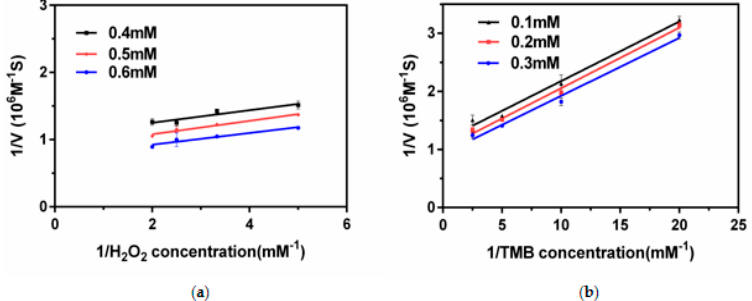
Figure 4. ( a ) Double–reciprocal plots at different H 2 O 2 concentrations, in which the concentration of TMB was fixed at 0.4, 0.5, and 0.6 mM; ( b ) double–reciprocal plots at different TMB concentrations, in which the concentration of H 2 O 2 was fixed at 0.1, 0.2, and 0.3 mM. Experiments were performed in triplicate to obtain the mean